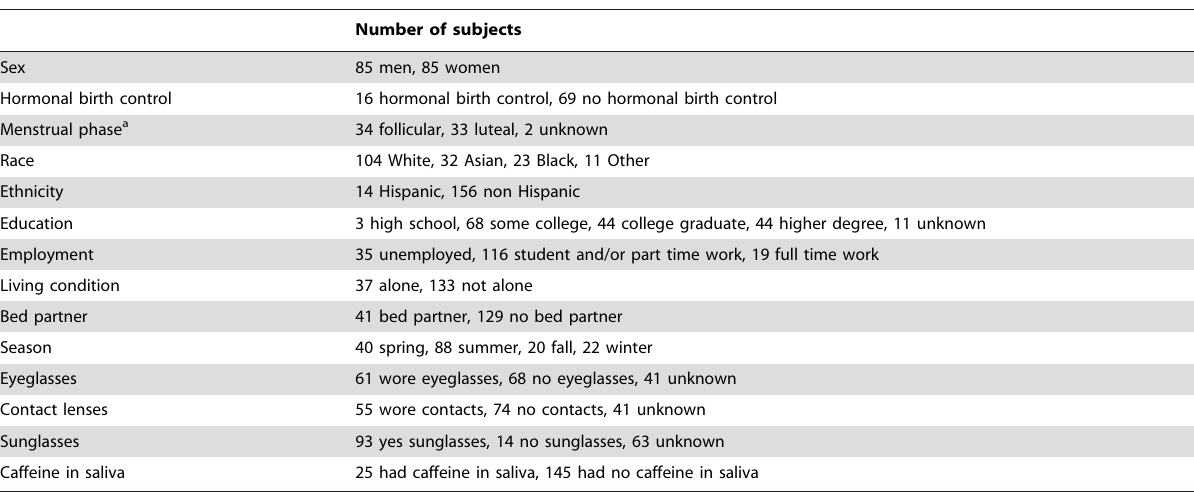
Table 2. Sample size of categorical demographic variables.